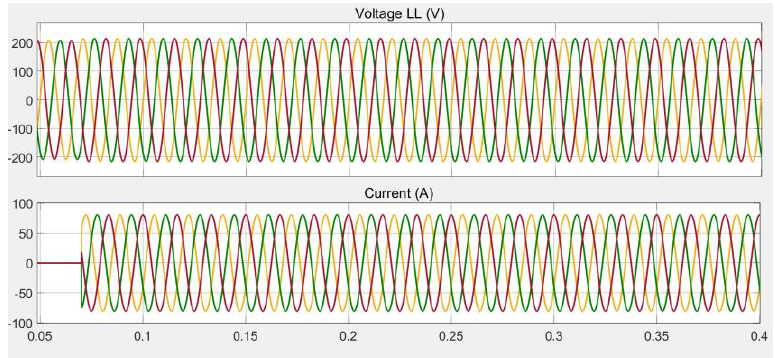
Figure 3. Signals at Bus 8.